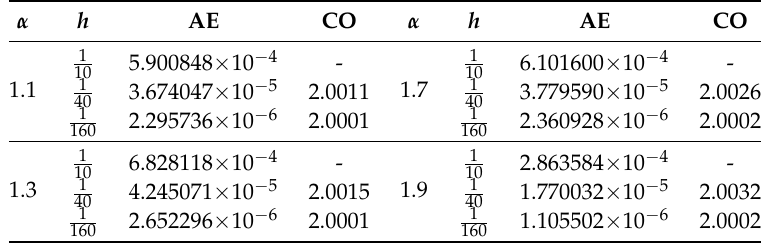
Table 13. Numerical results of Example 13 by using scheme (281) with n =